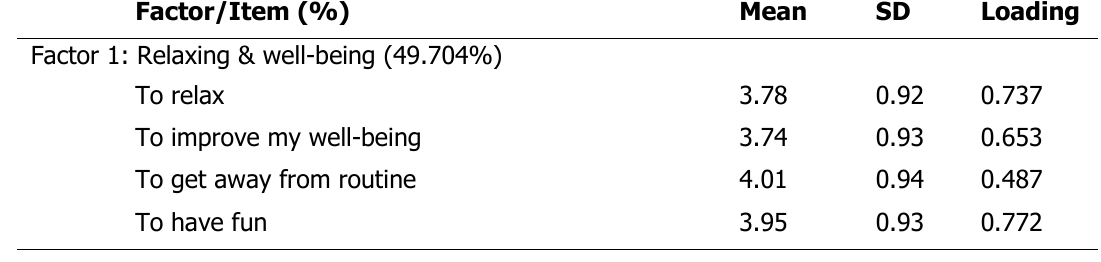
Table 4. Motivational factors to join virtual tours of Indonesian